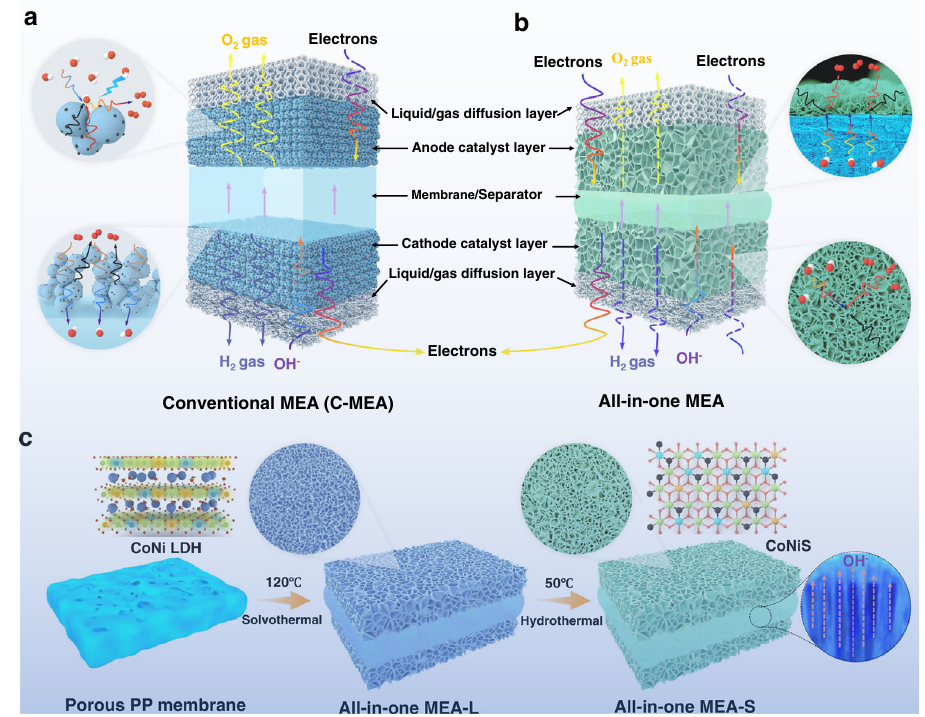
Fig. 1 | Schematic illustration of the all-in-one MEA concept and preparation process. a Conventional MEA (C-MEA) and b all-in-one MEA based on 3D-ordered transport highways. c Synthetic procedure for the all-in-one